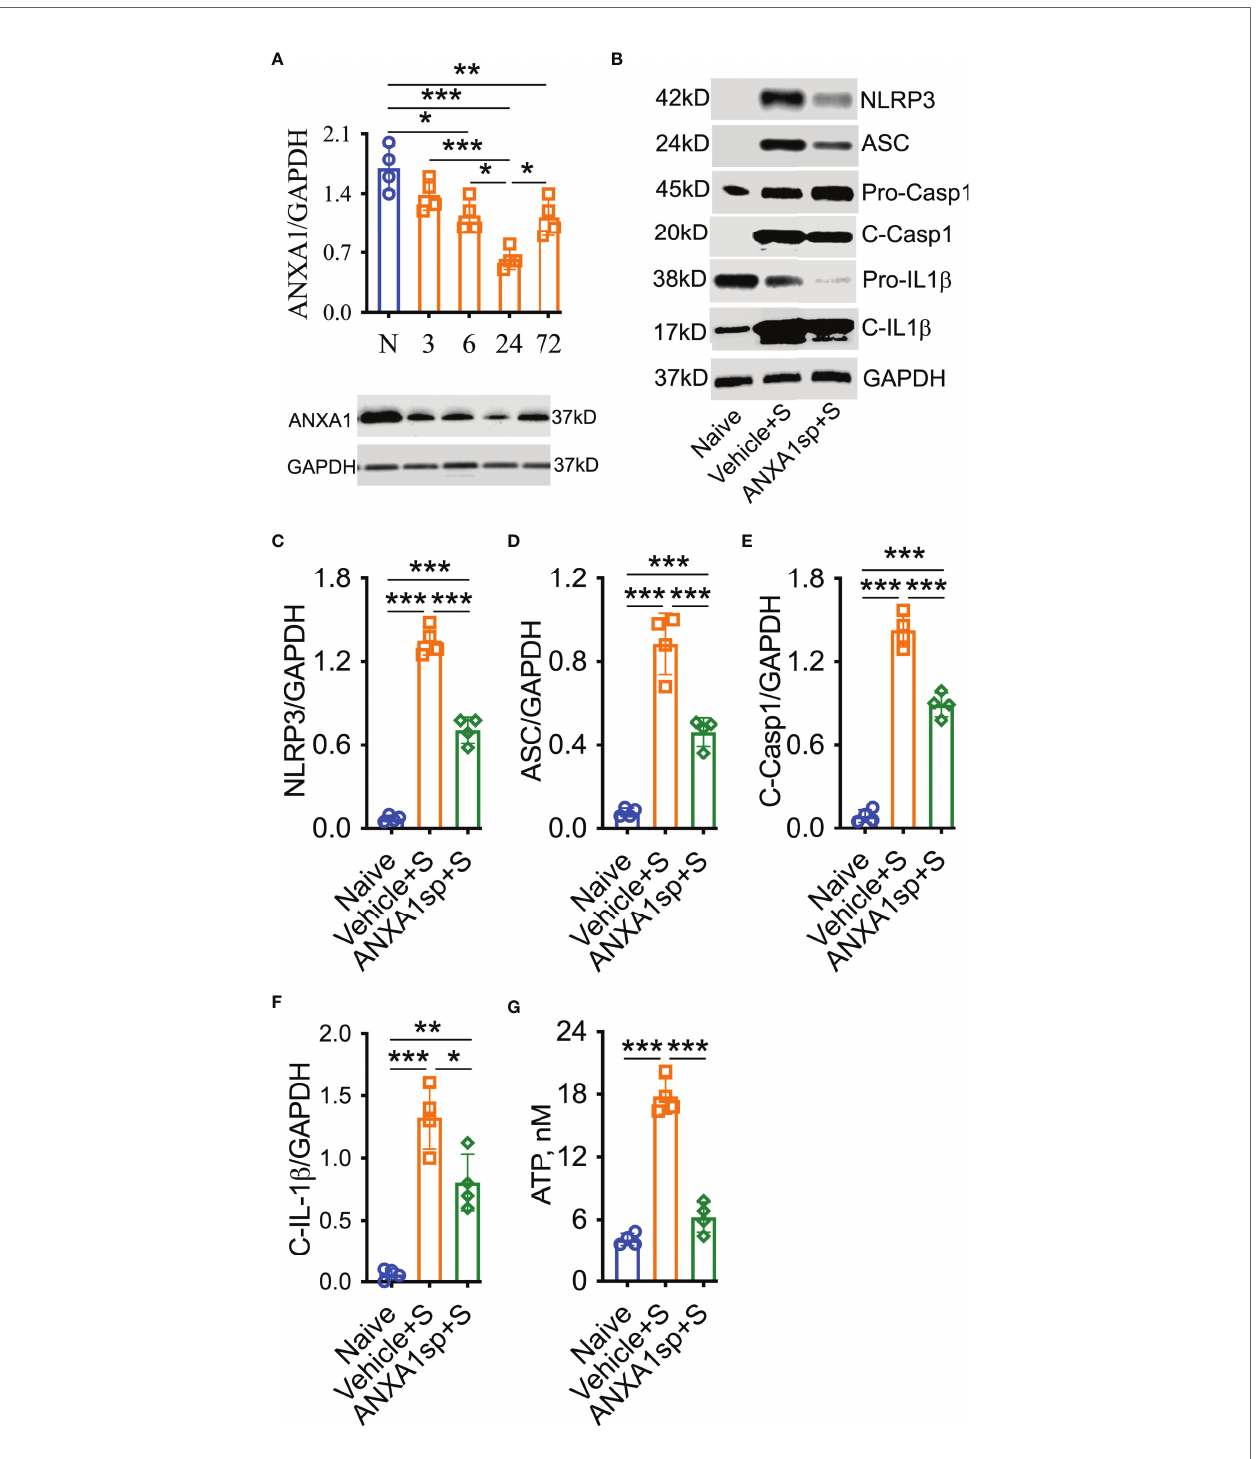
FIGURE 1 | Decreased ANXA1 expression and induction of the NLRP3 in fl ammasome in adult mice after orthopedic surgery. Surgery reduced the expression of endogenous ANXA1 in hippocampal homogenate in a time-dependent manner, with the lowest expression found at 24-h (A) . Hence, we treated mice with ANXA1sp (1 mg/ kg, i.p.) 30 min before surgery and evaluated NLPR3 in fl ammasome activation at this timepoint. Postoperative NLRP3 in fl ammasome activation was signi fi cantly attenuated by ANXA1sp (B, C) , as evidenced by Western blot analysis of ASC (D) , cleaved caspase-1 (E) , and cleaved IL-1 (F) in hippocampal homogenate. Surgery-induced hippocampal ATP was also reduced by ANXA1sp treatment (G) . Data are presented as mean ± SEM. n = 4/group. * P < 0.05, ** P < 0.01, *** P < 0.001; analyzed by one-way ANOVA with Bonferroni test. Representative data are from two independent